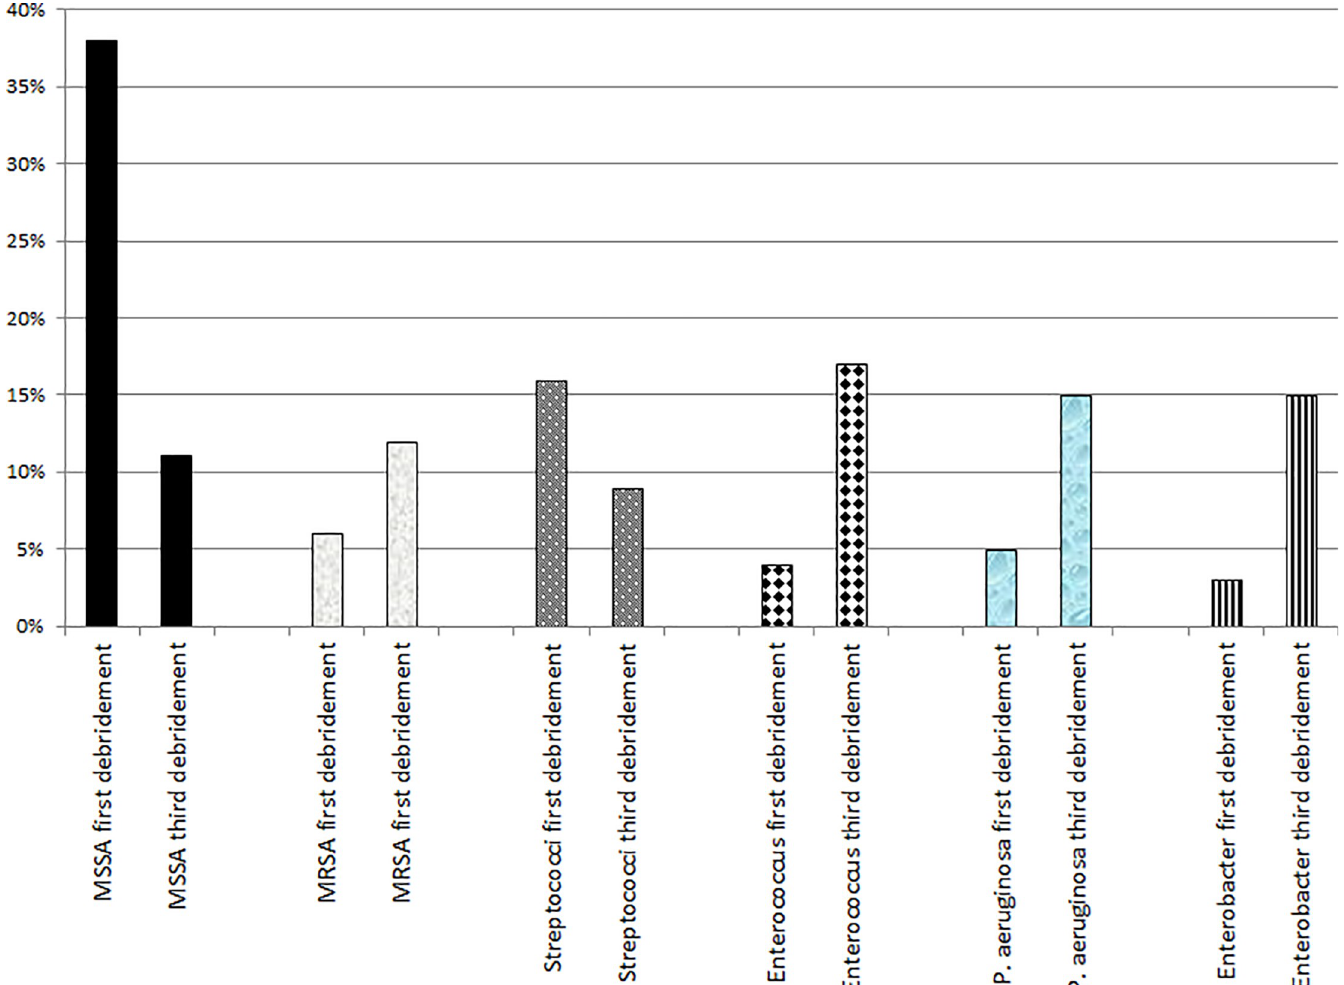
Fig 1. Changes of intraoperative pathogens (selected examples) from the first debridement to the third debridement for the same orthopedic infection. MSSA = Methicillin-susceptible Staphylococcus aureus . MRSA = Methicillin-resistant Staphylococcus aureus . P . aeruginosa = Pseudomonas aeruginosa . https://doi.org/10.1371/journal.pone.0226674.g001 PLOS ONE | https://doi.org/10.1371/journal.pone.0226674 December18,